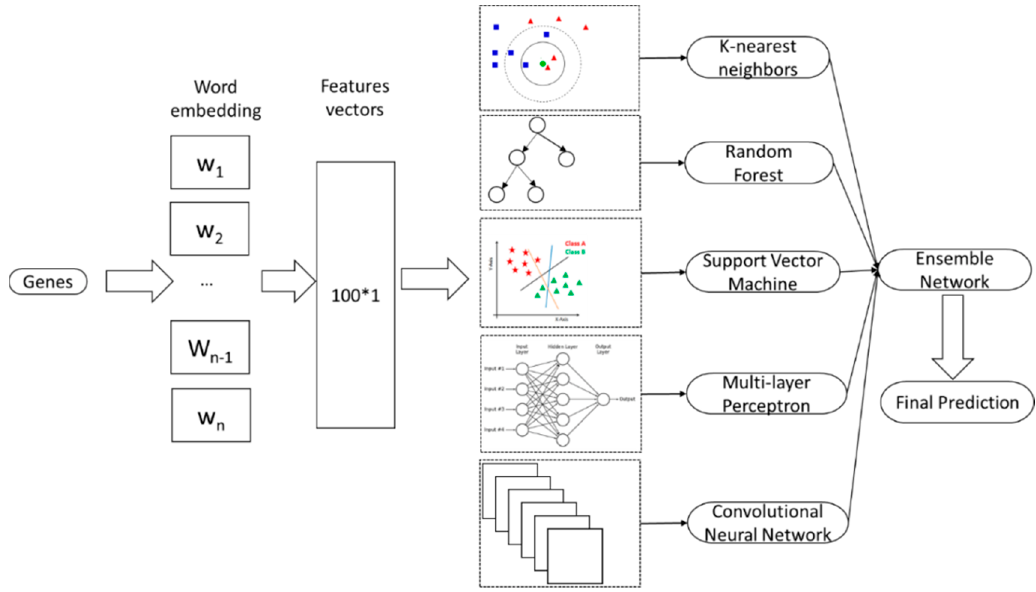
Figure 3. Work flow of the study in identifying essential genes using sequence information. The input was comprised of genes with di ff erent lengths and containing di ff erent nucleotides. The word-embedding features were extracted by using the fastText package and then learnt by an ensemble deep neural network. After the ensemble network, the output contained binary probabilities to show whether the represented genes belonged to essential genes. Red, green triangles, green circle, blue squares and red pentagons are examples of data